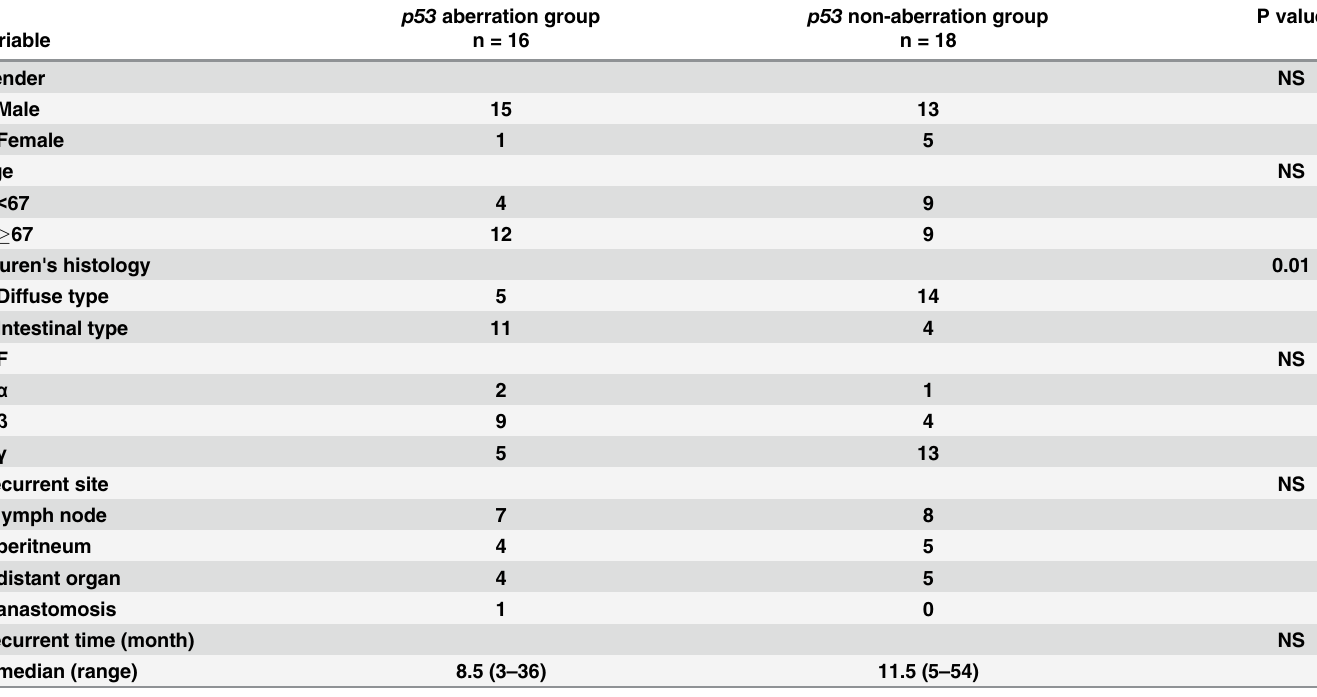
Table 2. Clinicopathological characters of recurrent tumors of pStage II/III gastric cancer in the p53 aberrant group (A) and the p53 non-aberrant group